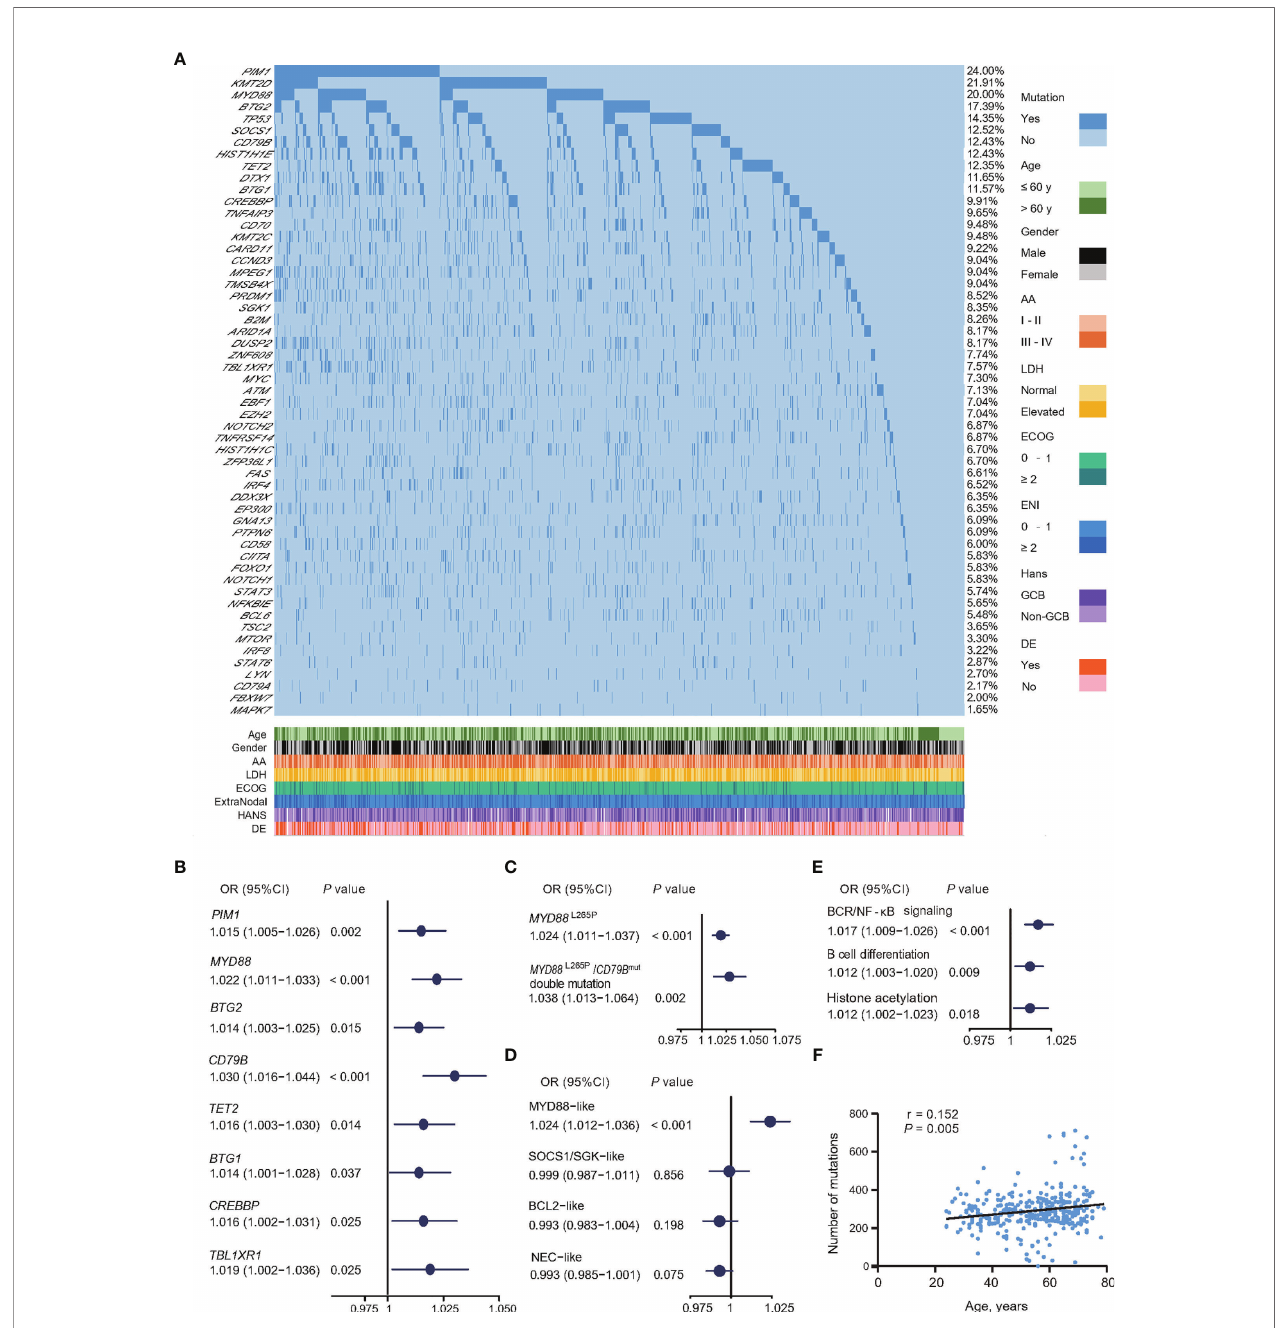
FIGURE 3 | Relationship between oncogenic mutations and age at diagnosis in DLBCL. (A) Oncogenic mutations identi fi ed by WGS/WES/targeted sequencing in DLBCL patients. (B) Univariate logistic regression analysis of oncogenic mutations according to age at diagnosis. (C) Univariate logistic regression analysis of MYD88 L265P mutations alone or with CD79B mutations according to age at diagnosis. (D) Univariate logistic regression analysis of genetic subtypes according to age at diagnosis. (E) Univariate logistic regression analysis of oncogenic pathways according to age at diagnosis. (F) Correlation between the number of oncogenic mutations sequenced by WGS/WES and age at diagnosis in DLBCL. (B – E) Odd ratios (OR), 95% con fi dence intervals (95% CI), and P -values are indicated on the left of each forest plot. DLBCL, diffuse large B-cell lymphoma; WGS, whole genome sequencing; WES, whole exome sequencing; AA, Ann Arbor; LDH, lactate dehydrogenase; ECOG, Eastern Cooperative Oncology Group; ENI, extranodal involvement; DE, double expressor; GCB, germinal center